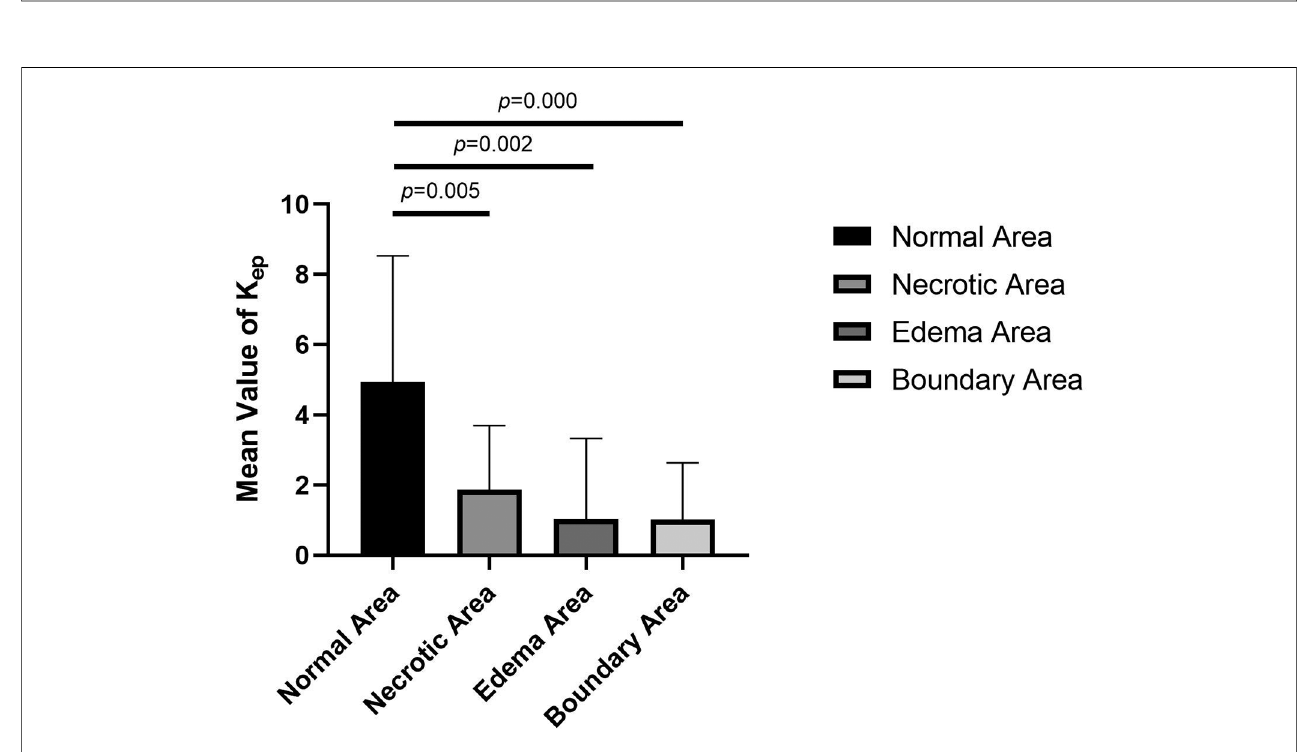
FIGURE 6 Comparison of the mean values of V e in normal, necrotic, edema, and boundary areas of femoral heads in patients with